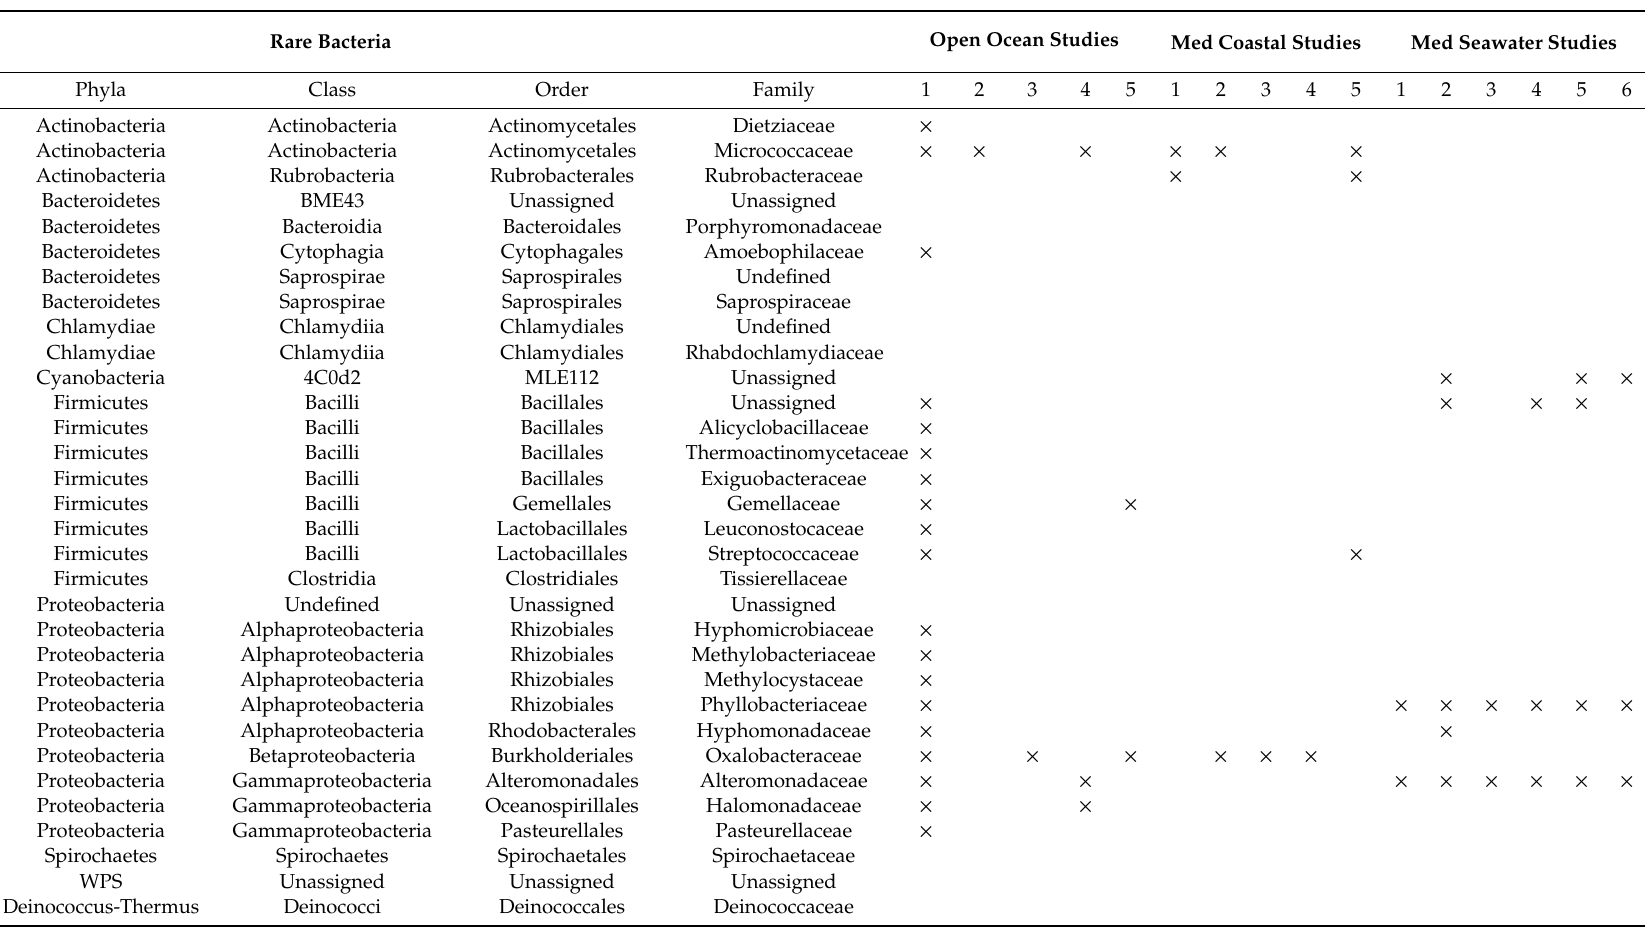
Table 3. ‘Rare’ organisms found over the Mediterranean Sea in this study compared to five studies focusing on marine aerosols [1,8,38,55,56], five studies focusing on coastal aerosols [3,31,32,57,58], and six samples from one study focusing on Mediterranean surface seawater [59]. Columns under open ocean studies refer to references [1,8,38,55,56], columns under Mediterranean coastal studies refer to references [3,31,32,57,58], and columns under Mediterranean seawater samples refer to six samples from reference